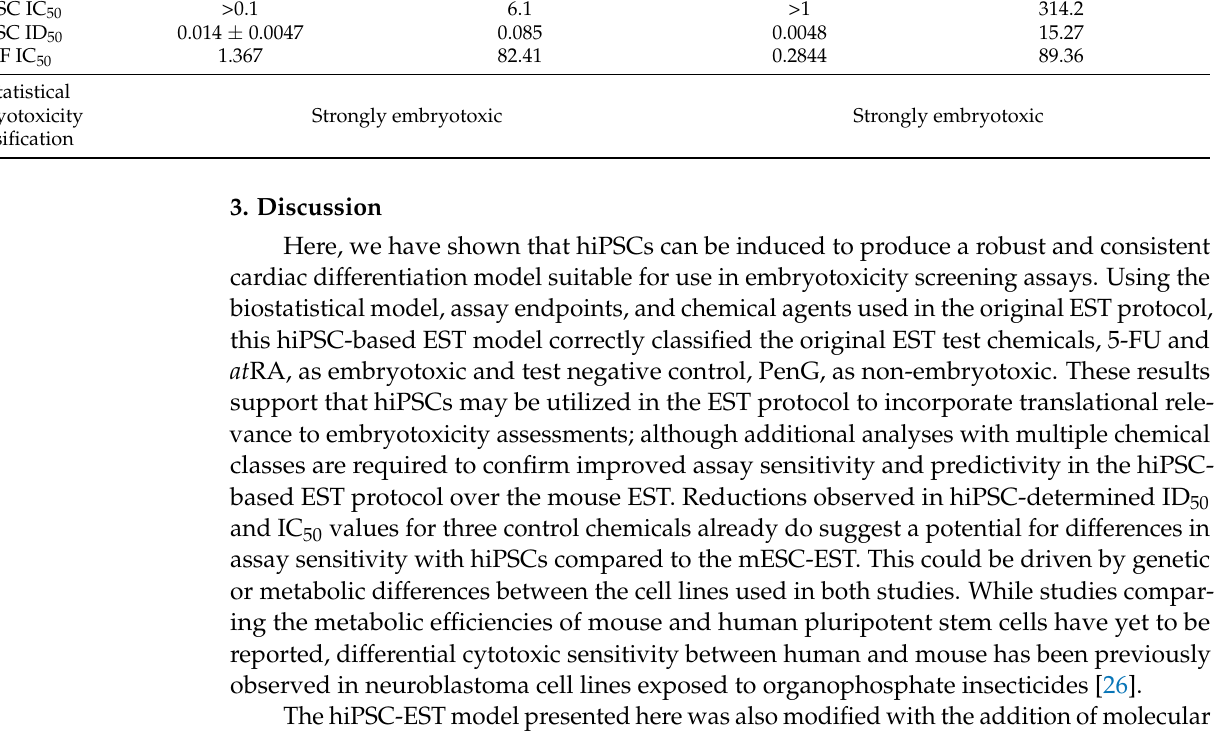
Table 3. List of IC 50 and ID 50 values determined from concentration-response curves for mainstream cigarette smoke and Snus smokeless tobacco. hiPSC, human induced pluripotent stem cell; hFF, human foreskin fibroblast. Toxicity